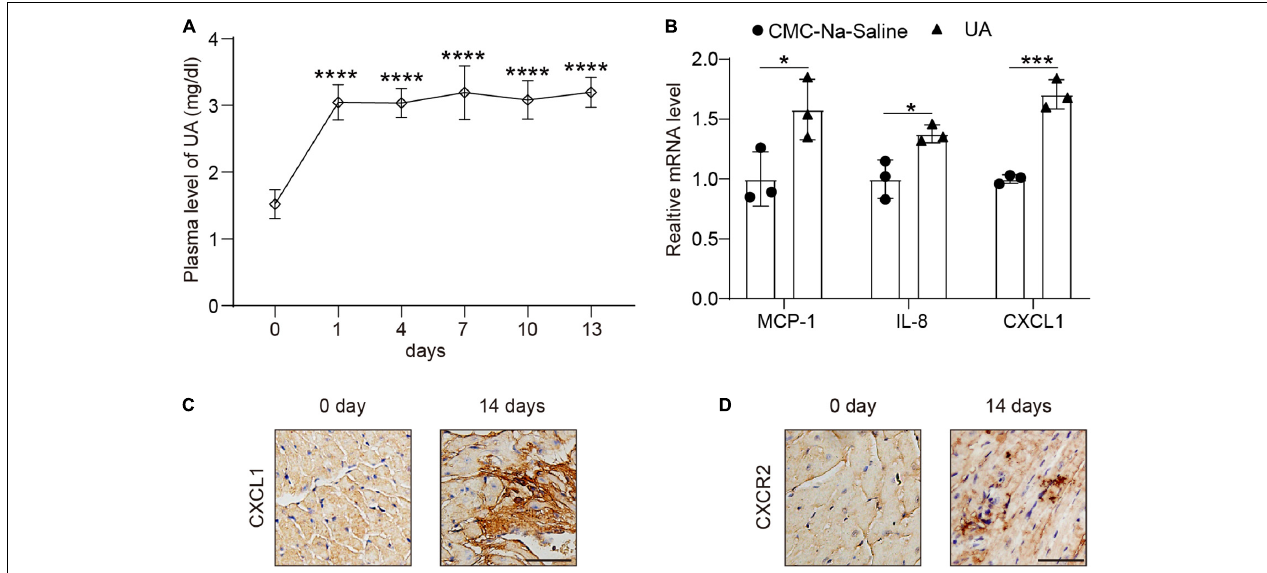
FIGURE 1 | Uric acid (UA) injection induced the upregulation of C-X-C motif chemokine ligand (CXCL1) in the hearts. Plasma levels of UA from mice subjected to carboxymethyl cellulose sodium (CMC-Na) saline or UA for day 14 were measured by ELISA (A) . Real-time PCR analysis of the messenger RNA (mRNA) expression of chemokines at day 14 in the same samples (B) . Representative images of immunohistochemistry (IHC) staining showing CXCL1 (brown color) accumulation within the hearts from mice subjected to CMC-Na-saline or UA at day 14 (C) . Representative images of IHC staining showing C-X-C motif chemokine receptor 2 (CXCR2) (brown color) within the hearts from mice subjected to CMC-Na-saline or UA at day 14 (D) . Statistical analysis was performed by one-way ANOVA ( Figure 1A ) and unpaired t-test ( Figure 1B ). * P < 0.05, *** P < 0.001, **** P < 0.0001 vs. CMC-Na-saline; n = 3/group.